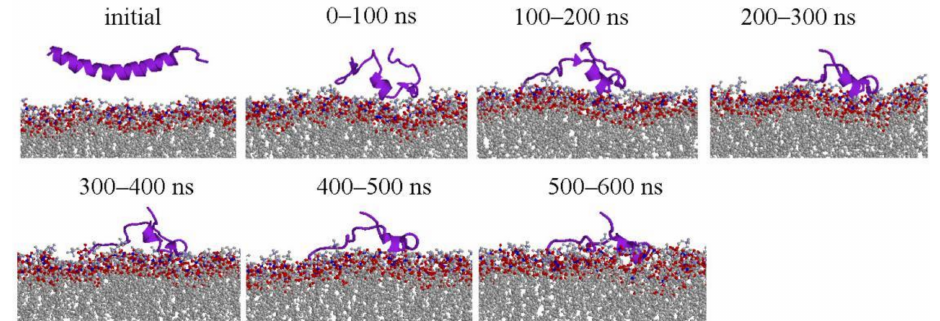
Figure 2. Representative structures of LL-37/POPC lipid (for Simulation 1). The side views of structure changes during the simulations at 100 ns intervals. Except the initial structures, each peptide structure shown at 100 ns interval is the center of clustering 100 ns conformations. Peptides, and phosphorus and oxygen atoms of lipid was colored purple, blue and red, respectively. Peptides were displayed with cartoon models and the others were displayed with ball and stick models by RasMol